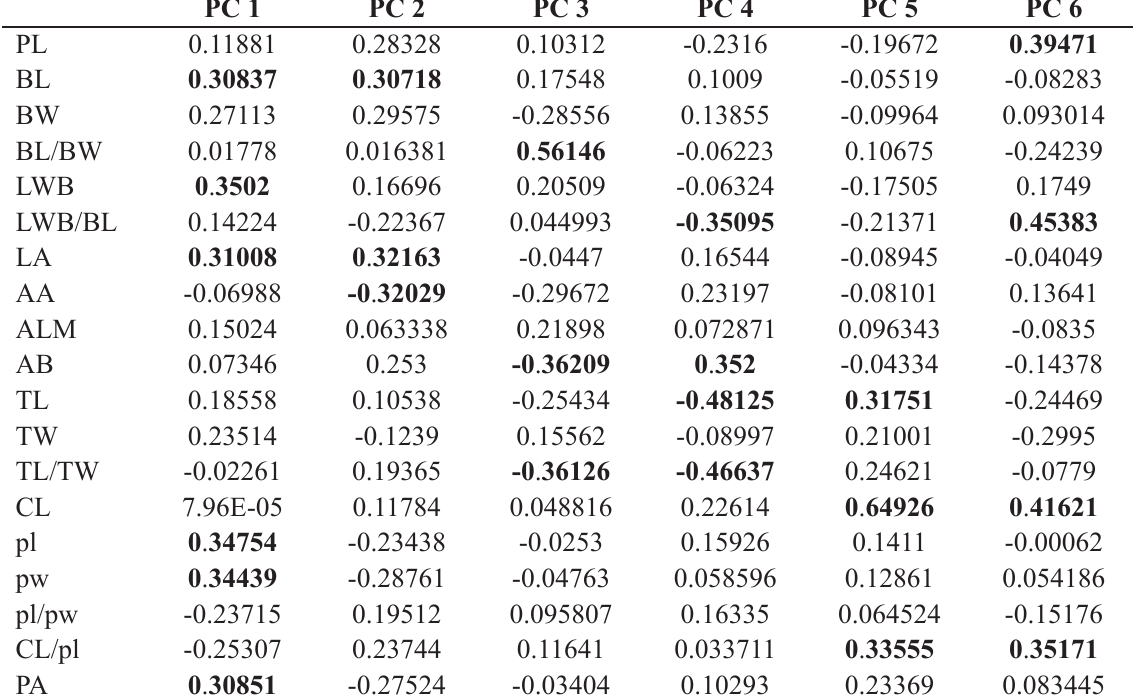
Table 4. Factor loadings for the first six principal components obtained from PCA based on 19 quantitative characters for the ‘fruiting season’ group of the selected species of Malus